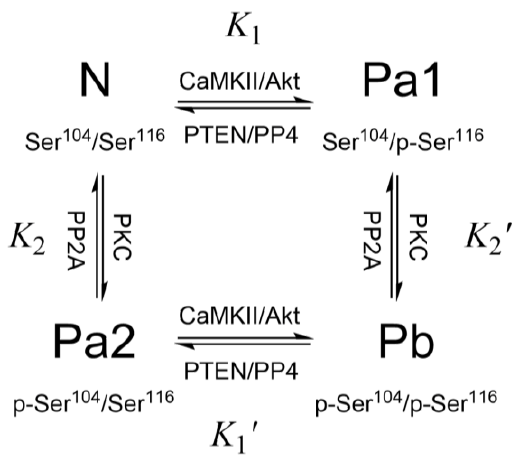
Figure 1. PEA-15 phosphorylation cycle. Ser 104 is phosphorylated by PKC, and Ser 116 is phosphorylated by CaMKII or PKB/Akt. PP2A is indicated to dephosphorylate p-Ser 104 , while PP4 is associated with dephosphorylation at p-Ser 116 . PTEN reduces p-Ser 116 content by deactivating Akt. The relative protein kinase/phosphatase activities mediate PEA-15 phosphorylation